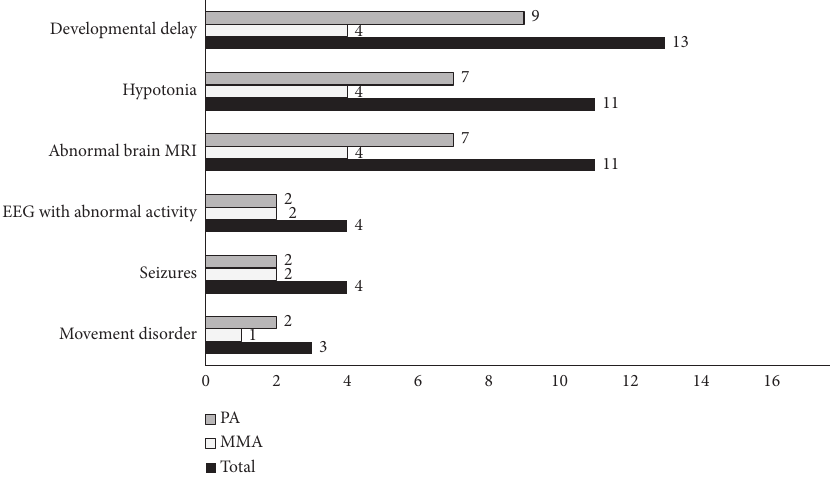
Figure 4: The most frequent neurological complication ( n